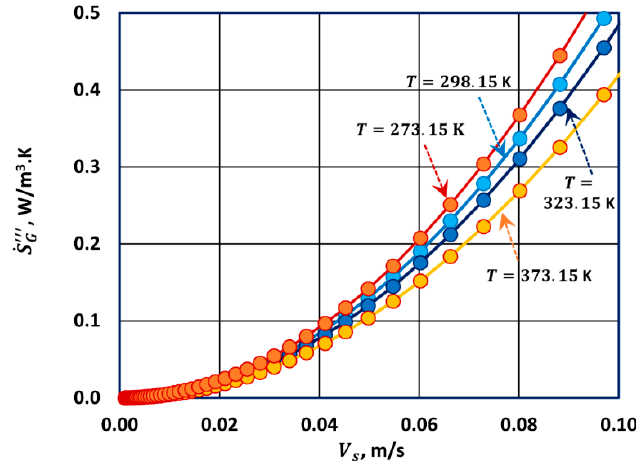
Figure 13. Effect of temperature on the rate of entropy generation per unit volume of the packed bed laminar flow ( ε = 0.40, d p = 1 mm, µ = 18.5 µ Pa · s, ρ = 1.184 kg / m 3 ). The data points are generated in laminar flow ( (cid:2013) = 0.40, (cid:1856) (cid:3043) = 1 mm, (cid:2020) = 18.5 µPa·s, (cid:2025) = 1.184 kg/m 3 ). The data points are using Equation (50). generated using Equation (50).